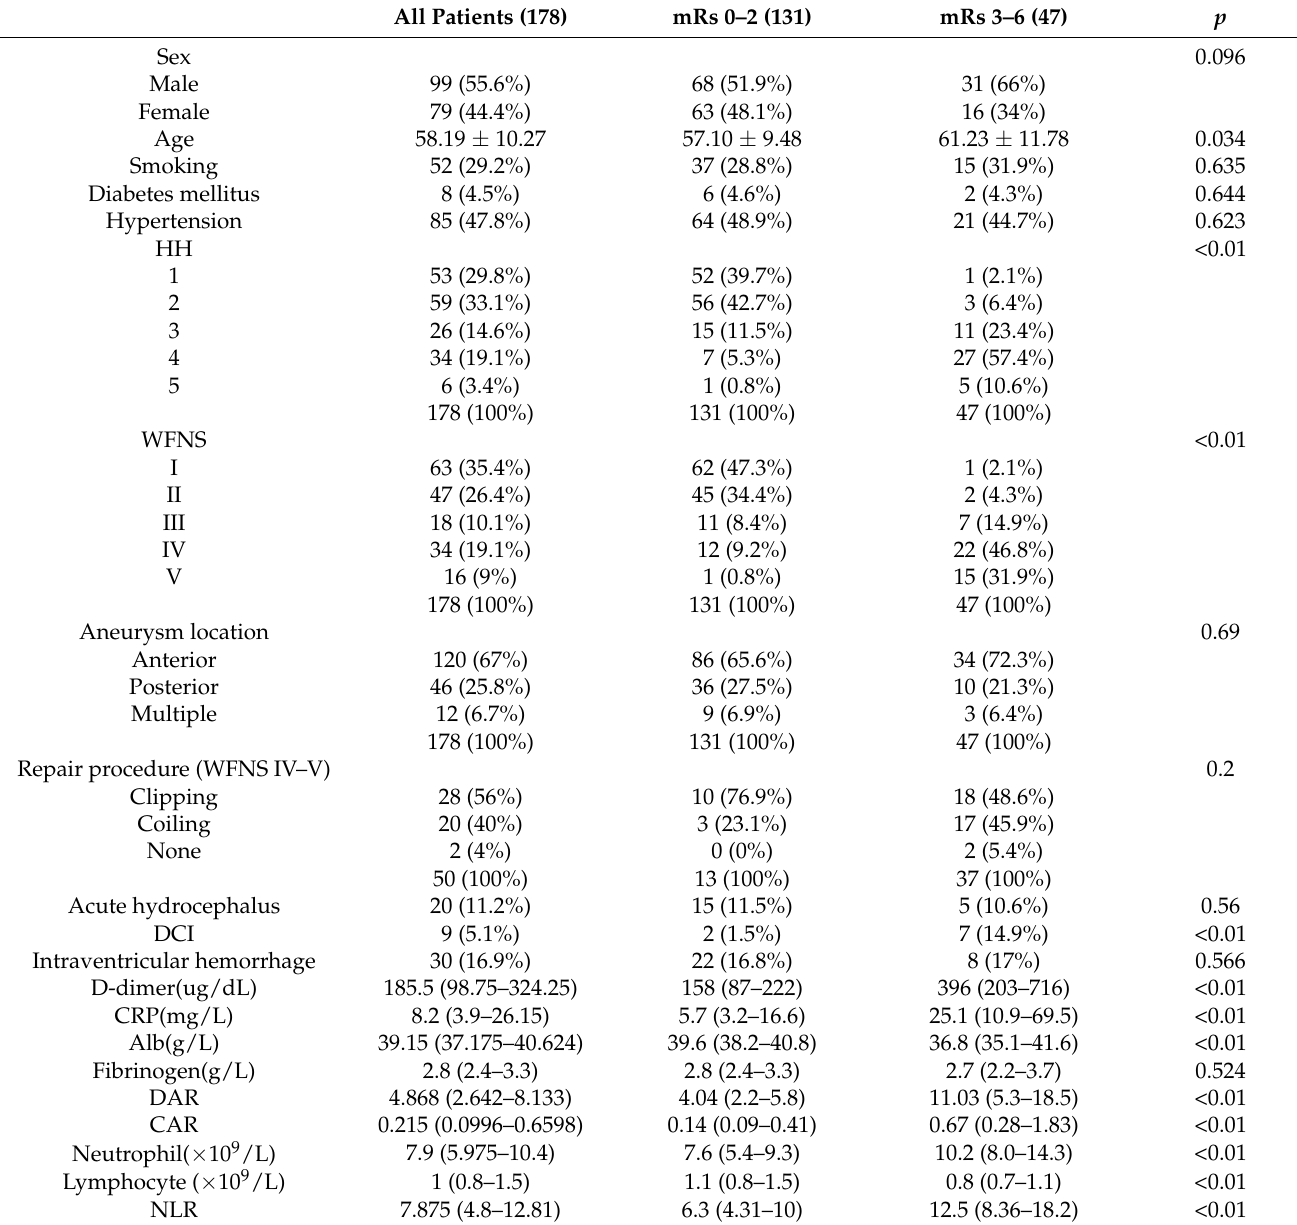
Table 1. Demographic characteristics of